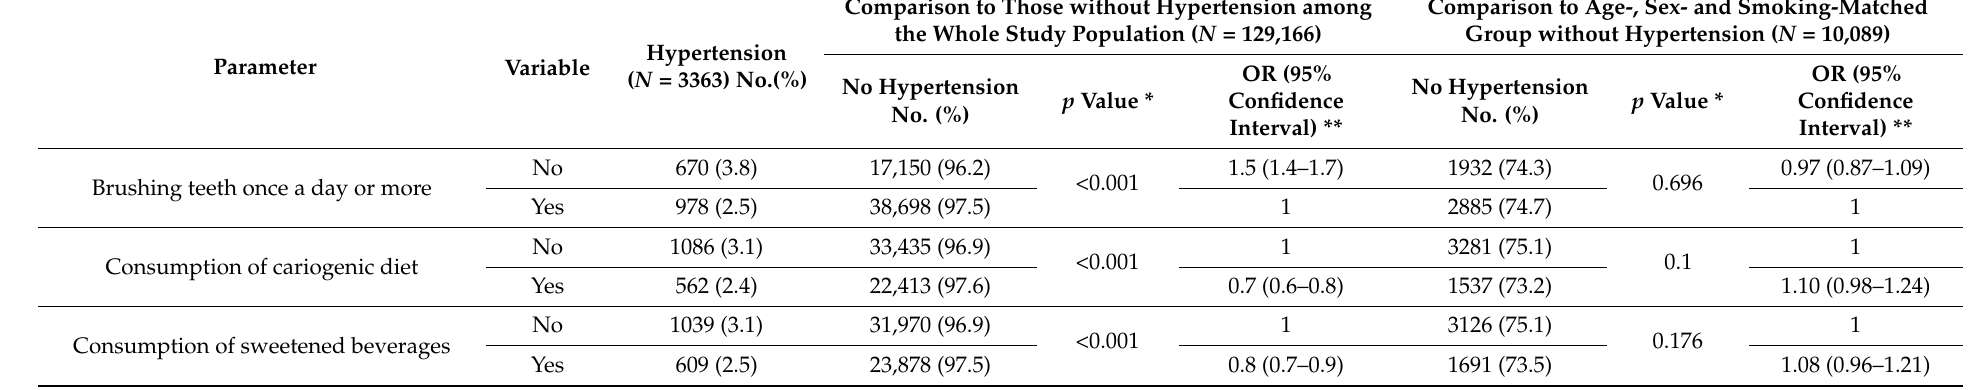
Table 2. The association of hypertension diagnosis with patient health-related habits and attendance patterns among the study population and among the age-, sex- and smoking-matched